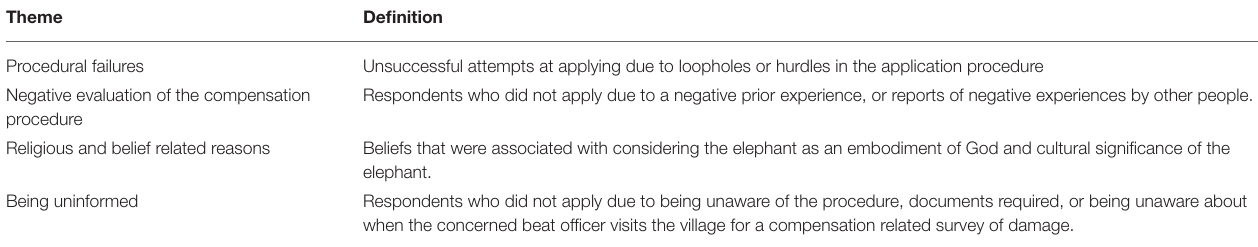
TABLE 1 | Table defining the key themes that emerged from reasons given for not claiming ex-gratia relief. Theme Definition Procedural failures Negative evaluation of the compensation